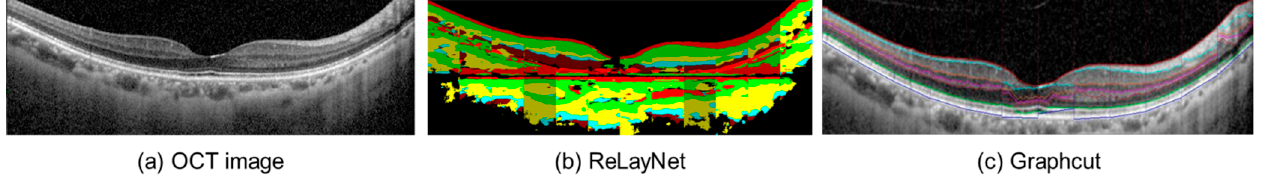
Figure 4. Example of the segmented OCT image ( a ) using RelayNet ( b ) and the graph-cut method ( c